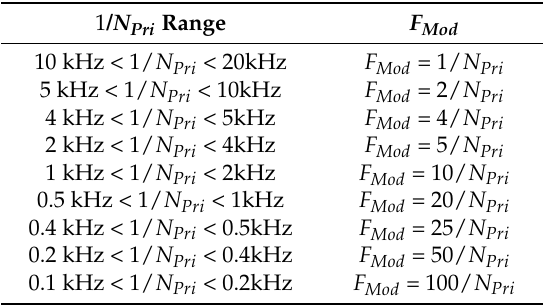
Table 1. Selection of the frequency modulation 𝐹 (cid:3014)(cid:3042)(cid:3031) based on the 𝑁 (cid:3017)(cid:3045)(cid:3036) value. 𝟏/𝑵 𝑷𝒓𝒊 Range